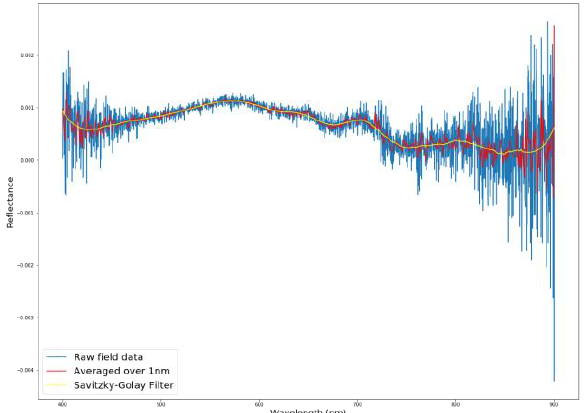
Figure 7. Sample spectral data smoothing using Savitzky-Golay